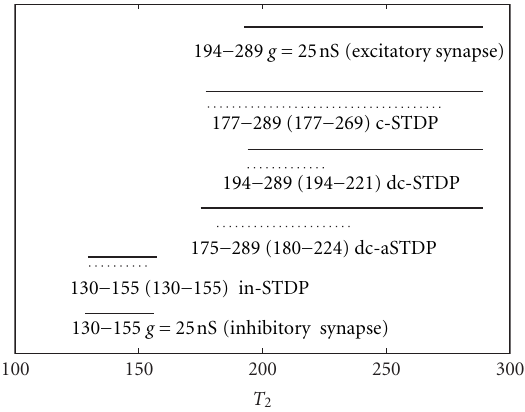
Figure 6: We present the optimal synchronization window for various learning rules compared with Figure 3. The top and the bottom lines of this figure are the synchronization windows of excitatory and inhibitory constant synapse, respectively. In addition, there are four pair lines in the middle panel for STDP rules. Each pair includes optimal synchronization window (top line) and previous synchronization window in Figure 3 (bottom line). The left range is optimal synchronization range and the range in round bracket is previous synchronization